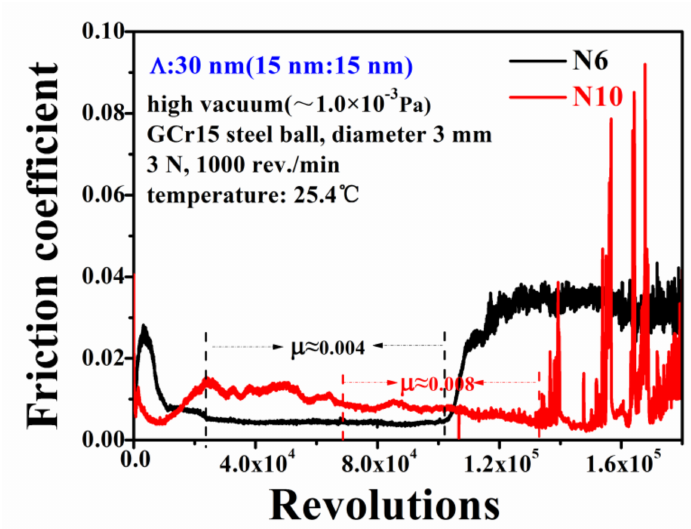
Figure 7. The friction coefficient curves of MoSN/MoS 2 multilayer films N6 and N10 tested in an ultrahigh vacuum for 1.8 × 10 5 sliding revolutions.